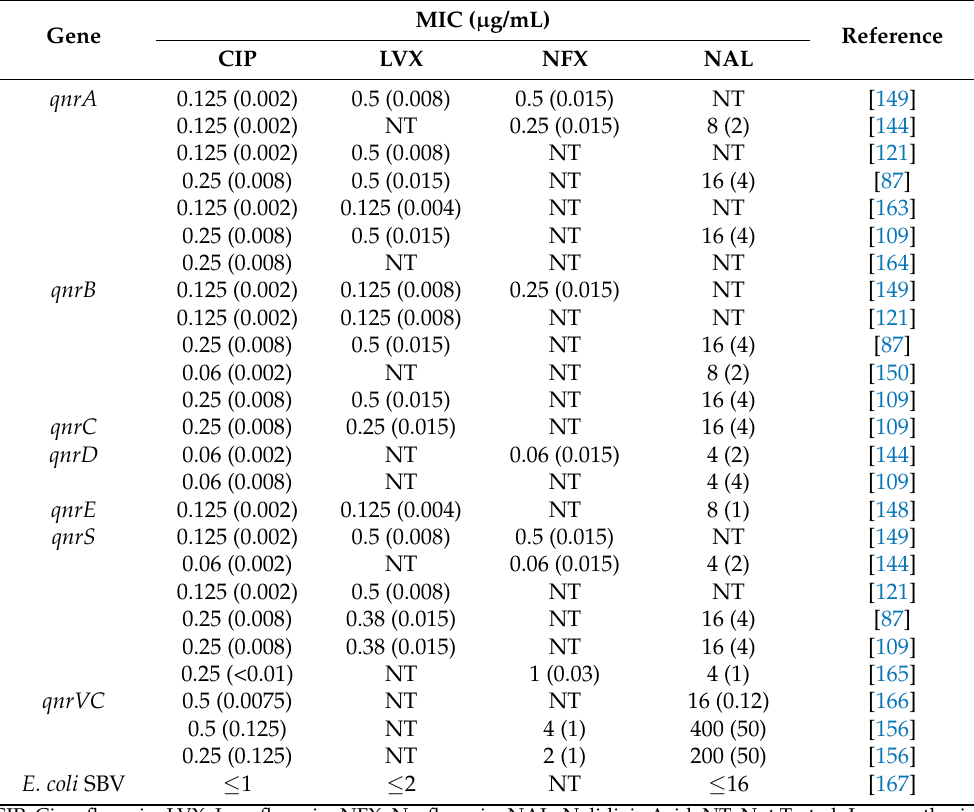
Table 3. Minimum Inhibitory Concentration (MIC) of various quinolones by the different alleles of the qnr gene, using Escherichia coli as a model